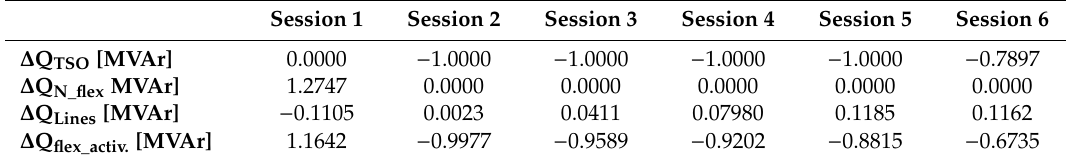
Table 2. Reactive power balance for increasing TSO inductive needs at each market session.